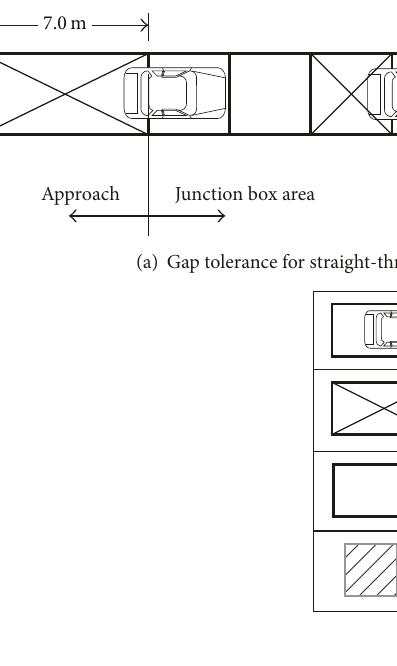
Figure 3: Gap tolerance rules of vehicle movements.